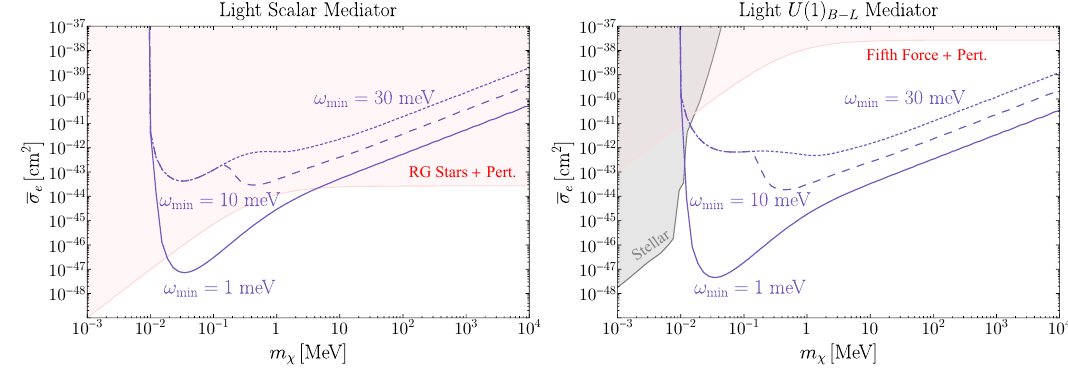
Figure 6 . Projected reach for a 5% subcomponent of DM scattering via a light (1 eV) hadrophobic scalar (left) or U(1) B (cid:0) L vector (right) mediator, assuming 1 kg-yr exposure with a GaAs target, 3 signal events and no background. Single phonon excitation reach is shown in purple, assuming energy thresholds ! min = 1 ; 10 ; 30 meV. Pink regions are excluded when taking into account the strongest constraint on the mediator-SM coupling | red giant (RG) stars and (cid:12)fth force experiments for the two models respectively [62] | together with perturbativity (Pert.) of the mediator- (cid:31) coupling. In the U(1) B (cid:0) L case, the gray region is excluded by stellar production of (cid:31)